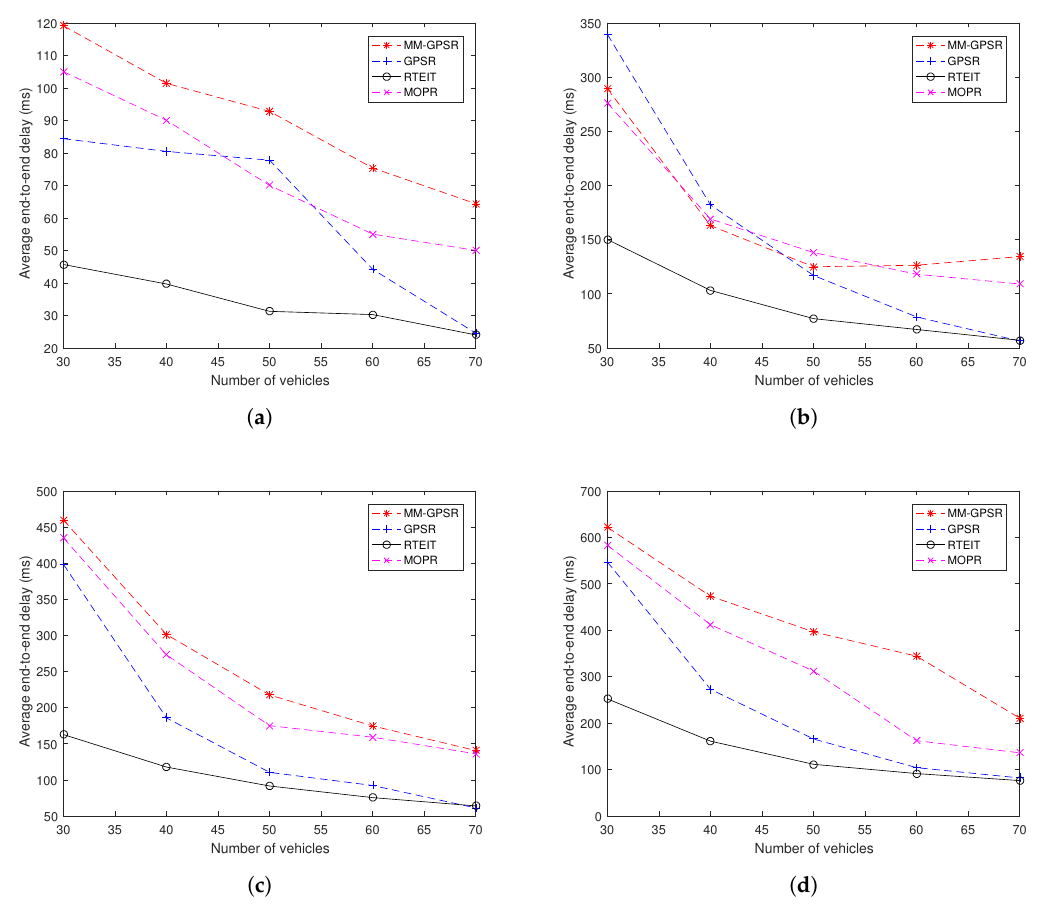
Figure 11. End-to-end delay for varying the number of vehicles and CBR connections: ( a ) 5 CBR connections; ( b ) 10 CBR connections; ( c ) 15 CBR connections; ( d ) 20 CBR